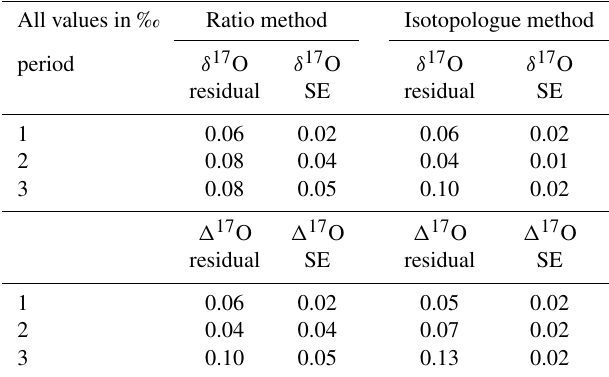
Table 9. Average of the residuals from the assigned value and mean of the standard error of the quality control gas δ 17 O and δ 17 O mea- surements per period for both the RM and the IM. All values in